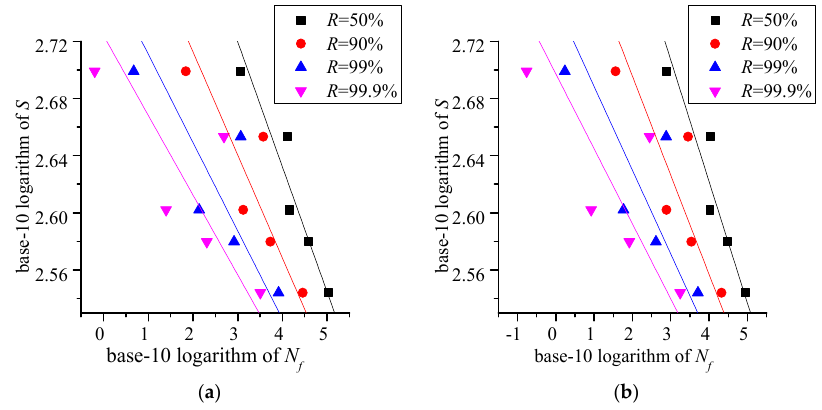
Figure 8. The P-S-N curves with R a = 1.6 µ m and confidence level ( a ) γ = 95%; and ( b ) γ = 99% Table 4. Parameters of P-S-N curves with R a = 0.4 µ m.